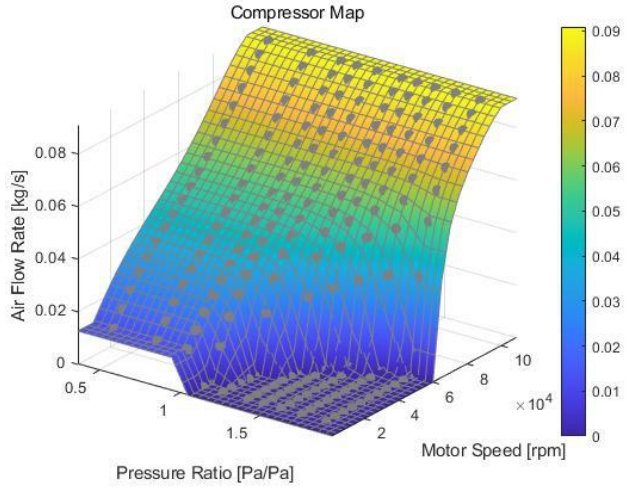
Figure 8. Compressor map.